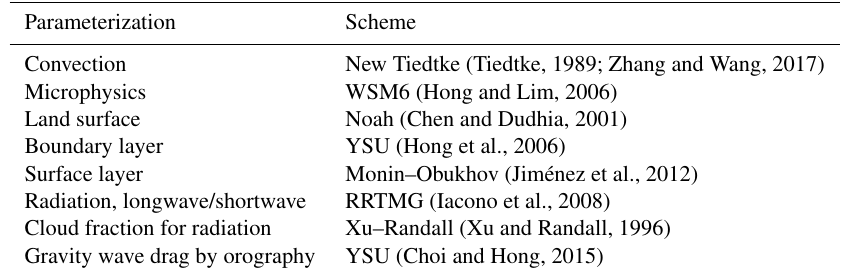
Table 2. Parameterization schemes in the “mesoscale reference” physics suite.